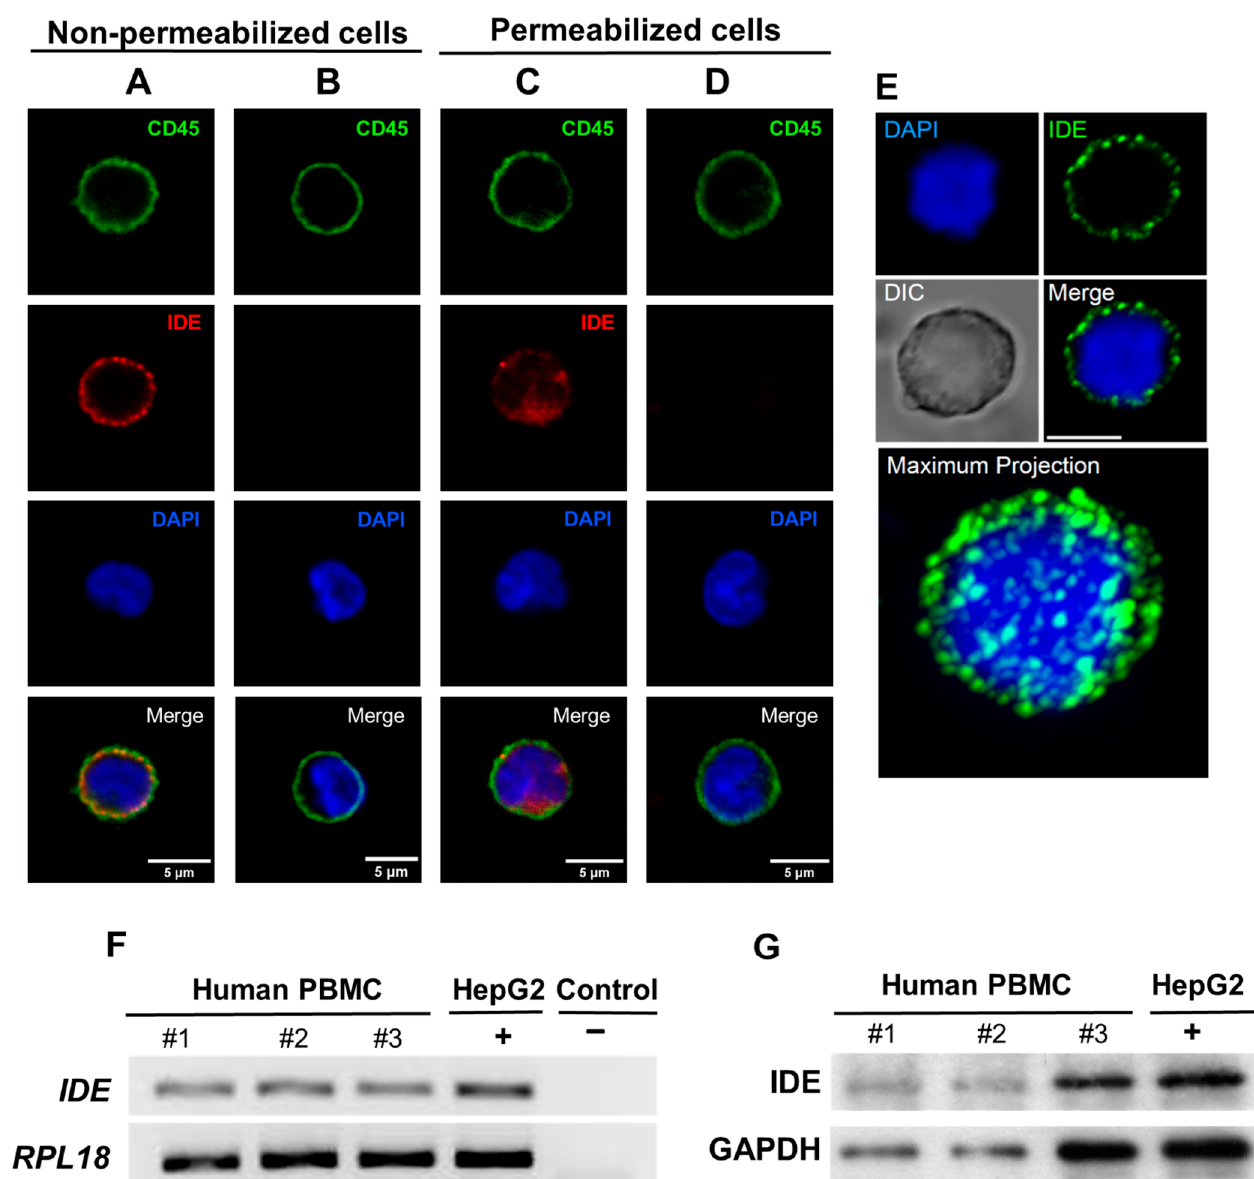
Figure 1. IDE expression in human peripheral blood mononuclear cells. ( A ) Representative fluores- cence microscopy images of an IDE signal obtained with confocal microscopy in non-permeabilized human PBMCs. ( B ) Control experiments without the primary antibody anti-IDE in non-permea- bilized cells. Calibration bar: 5 µm. ( C ) Representative image showing the specificity of IDE staining in permeabilized PBMCs. ( D ) Control experiments without the primary antibody anti-IDE in per- meabilized cells. Calibration bar: 5 µm. ( E ) Representative image showing the maximal projection of a Z-stack. ( F ) IDE expression levels. mRNA was extracted from three healthy subjects (#1, #2, and #3), amplified, and resolved in an agarose gel, as described in the methods section, with human hepatocytes as a positive control (HepG2 cell line). As a negative control, PCRs were run without a cDNA template. Human RPL18 was used as a housekeeping gene. ( G ) IDE expression levels. The total proteins were extracted from three healthy subjects (#1, #2, and #3) and subjected to Western blot analyses, as described in the methods section, with human hepatocytes as a positive control (HepG2 cell line). GAPDH was used as a loading control. 2.2. IDE Surface Expression Varies among the Different Subsets of Human PBMCs Having proved that IDE is expressed on the surface of human PBMCs, we next aimed to identify whether it was expressed on all circulating PBMCs or if, on the contrary, its